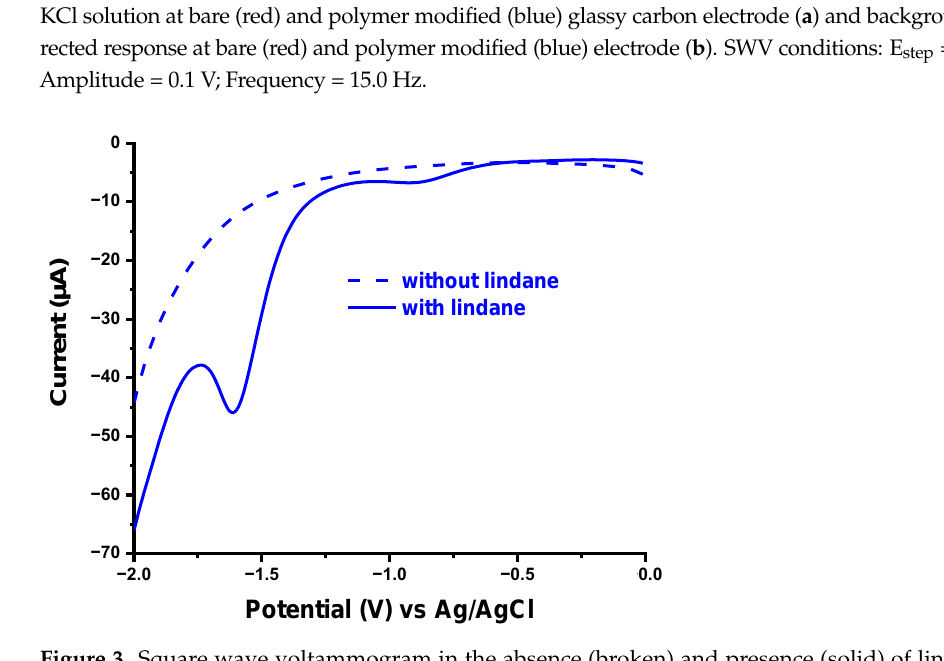
Figure 3. Square wave voltammogram in the absence (broken) and presence (solid) of lindane in nitrogen saturated 0.2 M KCl solution at glassy carbon electrode. SWV conditions: E step = 0.01 V; Amplitude = 0.1 V; Frequency = 15.0 Hz.